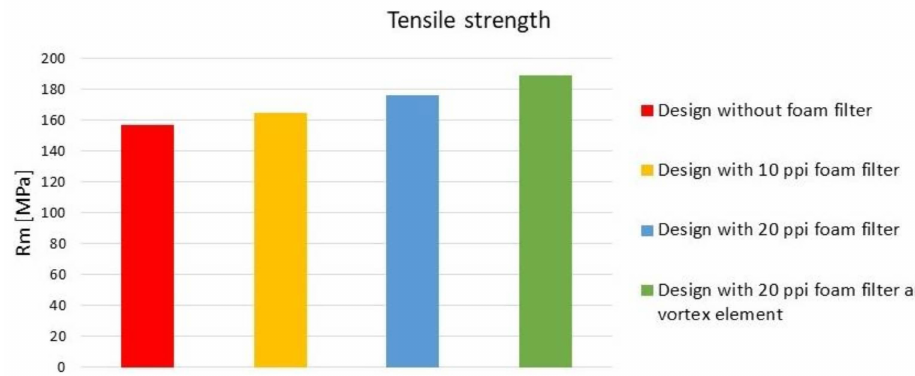
Figure 9. Results of tensile strength evaluation.